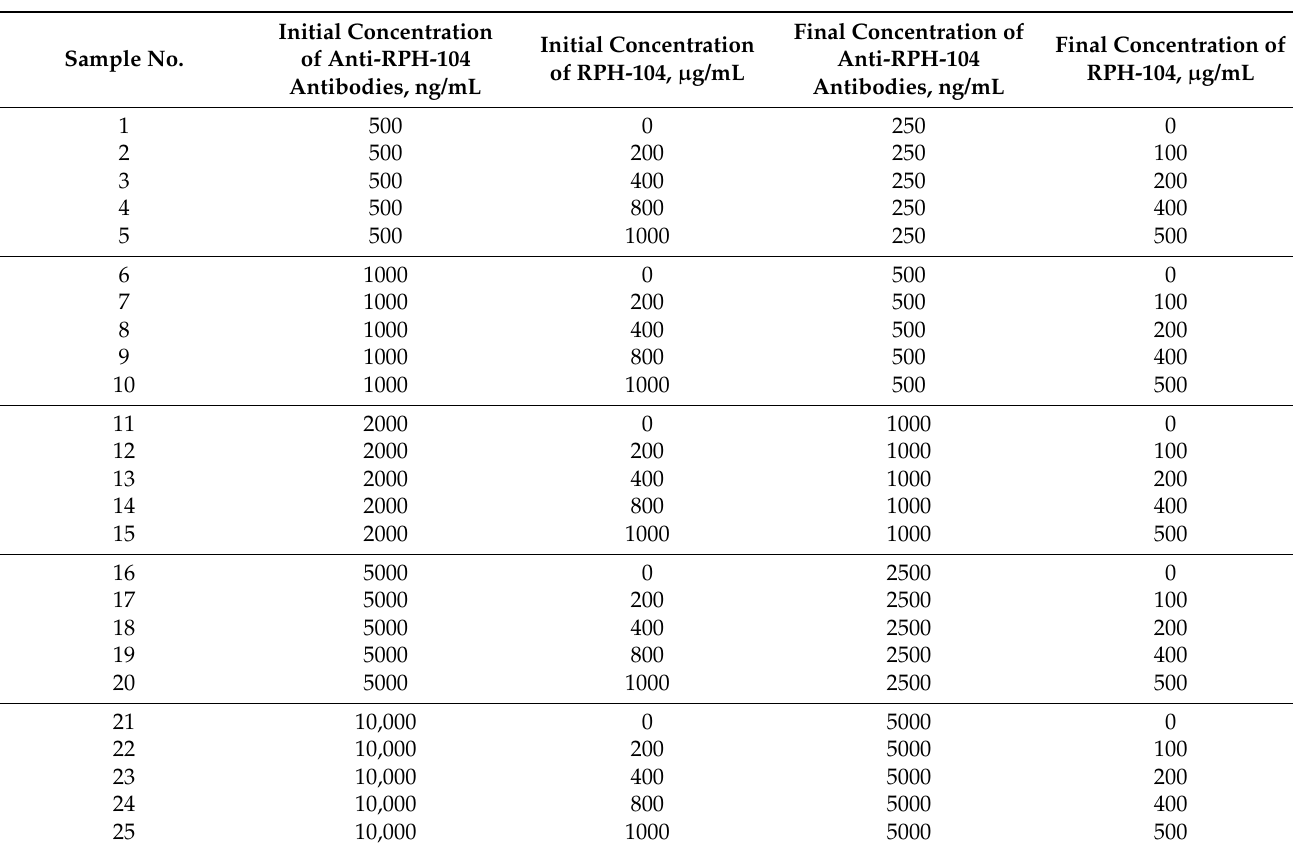
Table 1. Sample composition for drug tolerance examination.